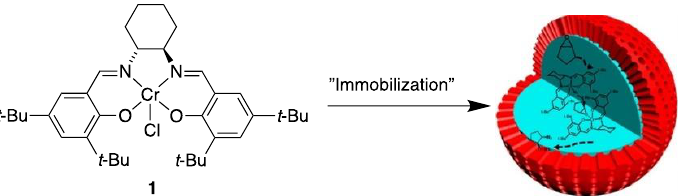
Figure 13. A liquid-solid hybrid catalyst. Adapted with permission from Reference [53]. Copyright 2019 American Chemical Society.